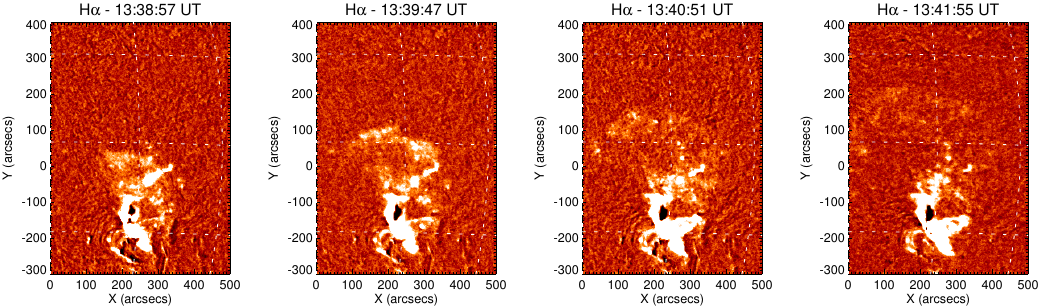
Figure 9: The Moreton wave of 1998 May 2 observed in H α (line center) at Kanzelh¨ohe Solar Observatory. Shown are difference images from which a pre-event frame has been subtracted. The wave is visible as an arc-shaped front of increased emission that becomes more diffuse as it propagates away from the flaring AR (adapted from Warmuth et al. , 2004a).